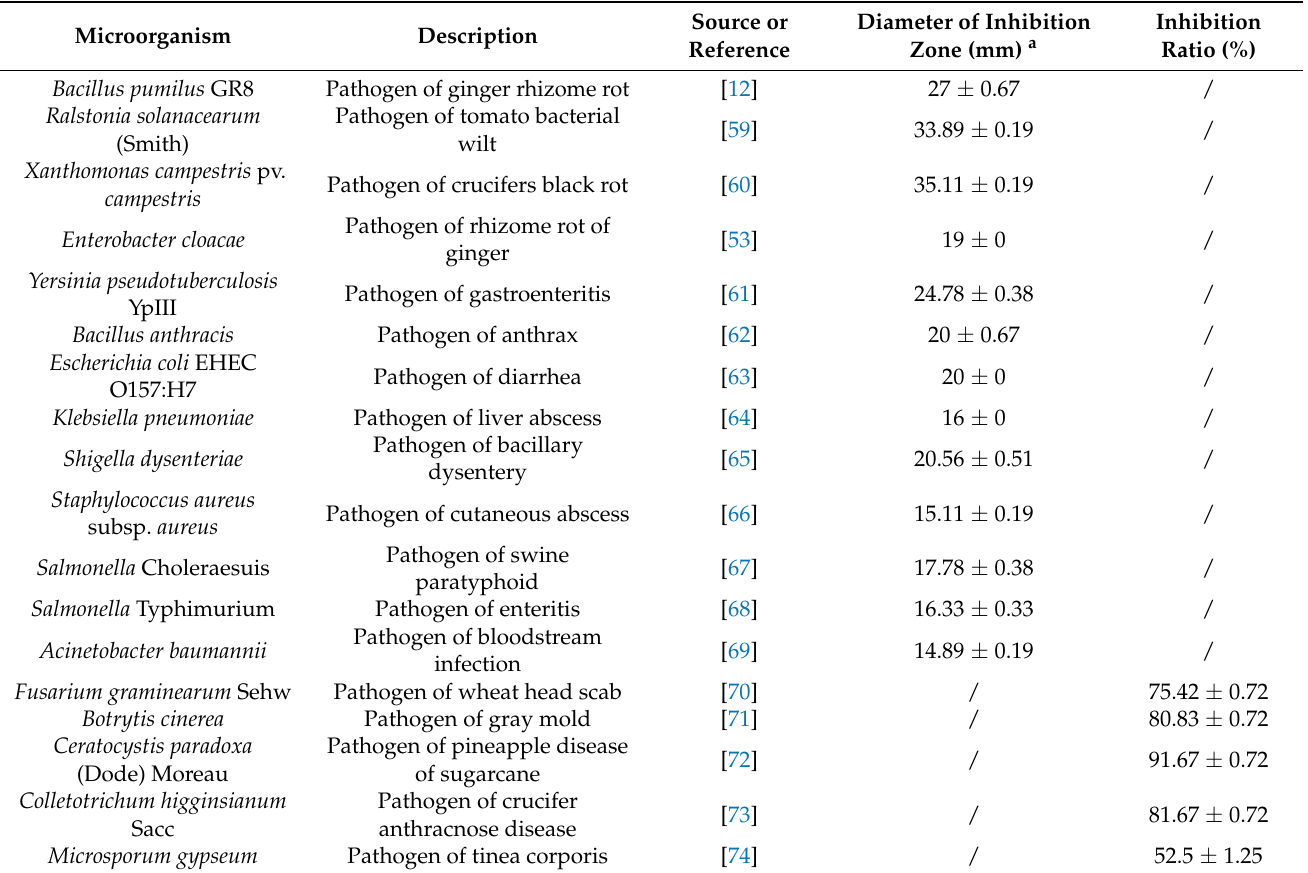
a Means and standard deviations were statistically calculated using the software package SPSS